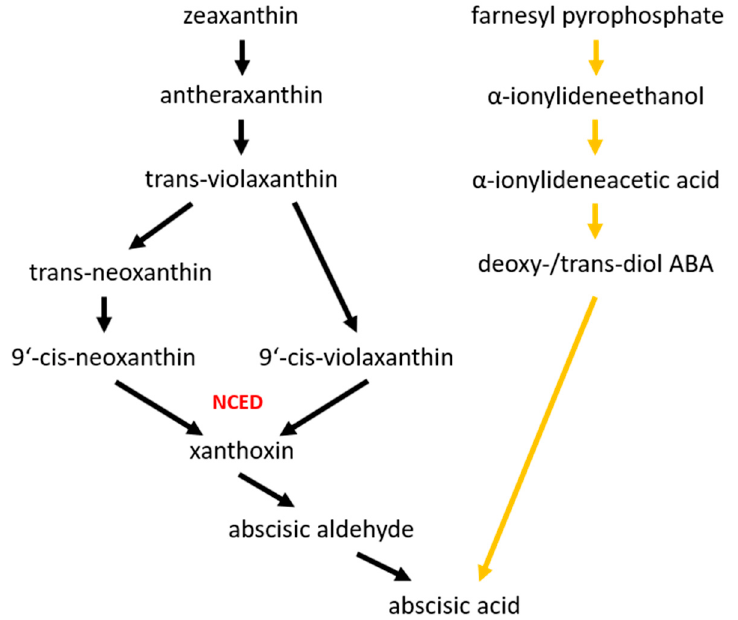
Figure 2. Abscisic acid biosynthetic pathways; the C 15 pathway is indicated by orange